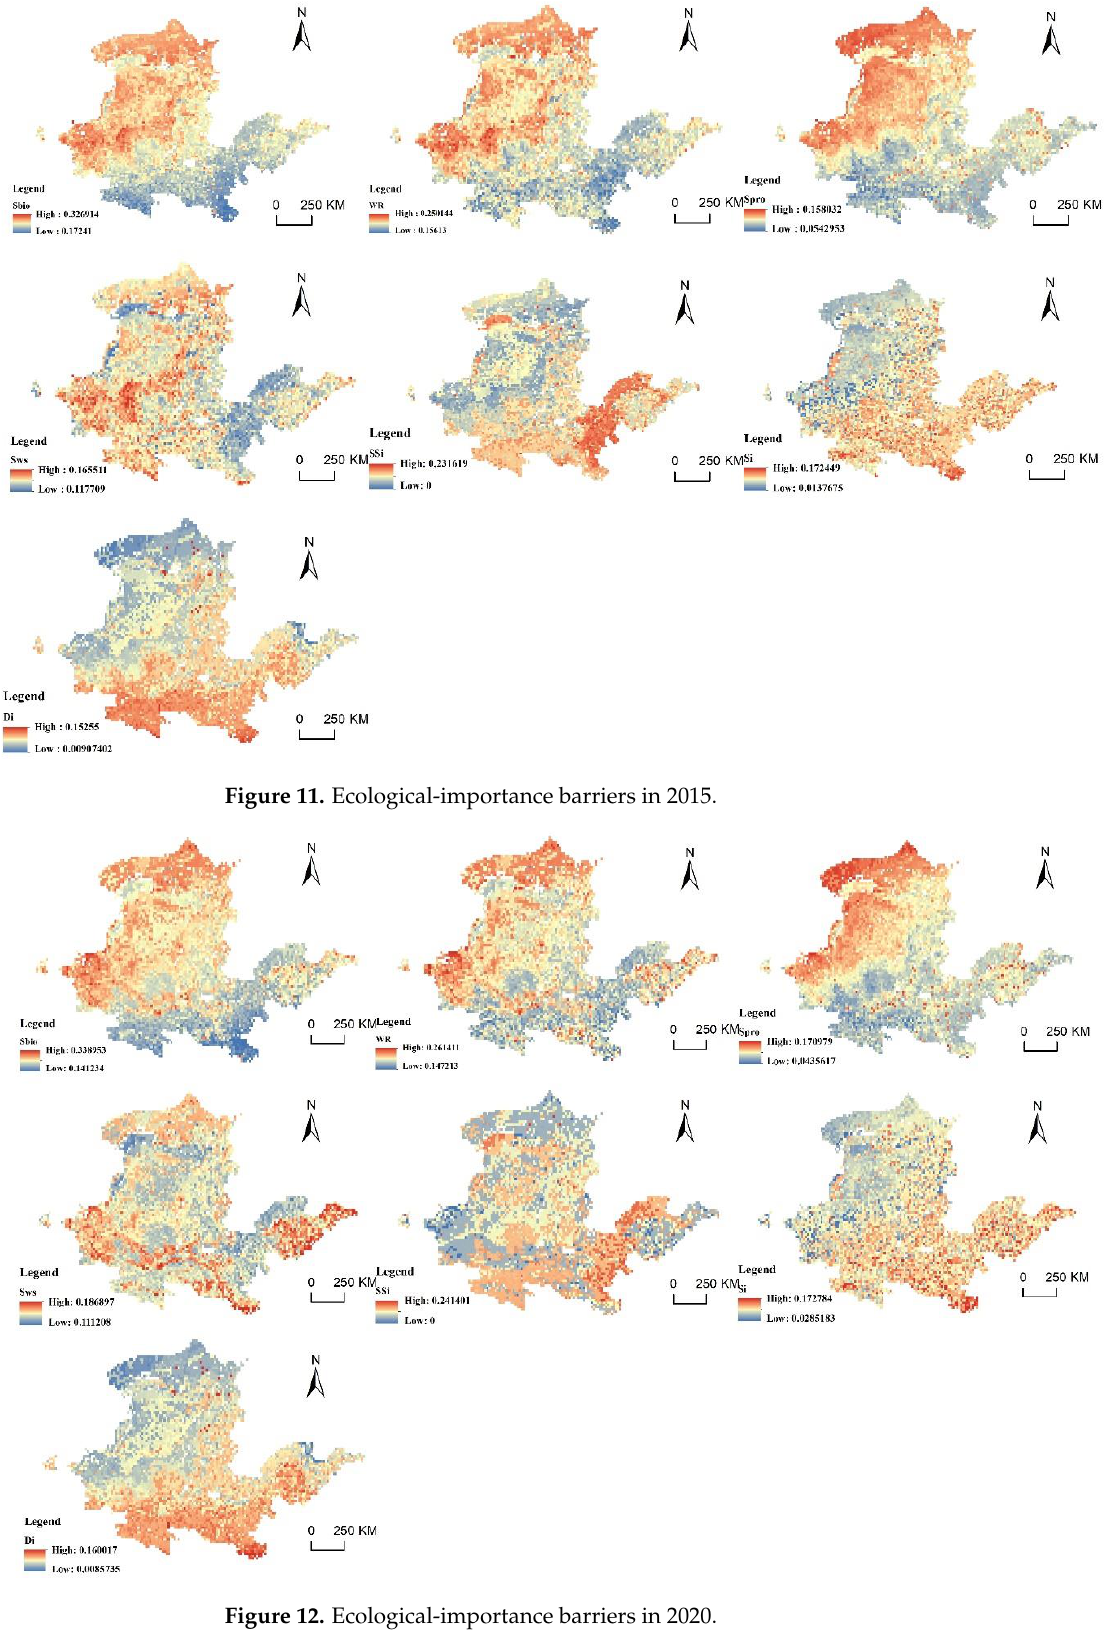
Figure 12. Ecological-importance barriers in 2020. The obstacle factors of PLES suitability of each city in the study area in 2010, 2015 and 2020 were calculated using Equations (3) and (4), and the top three obstacle